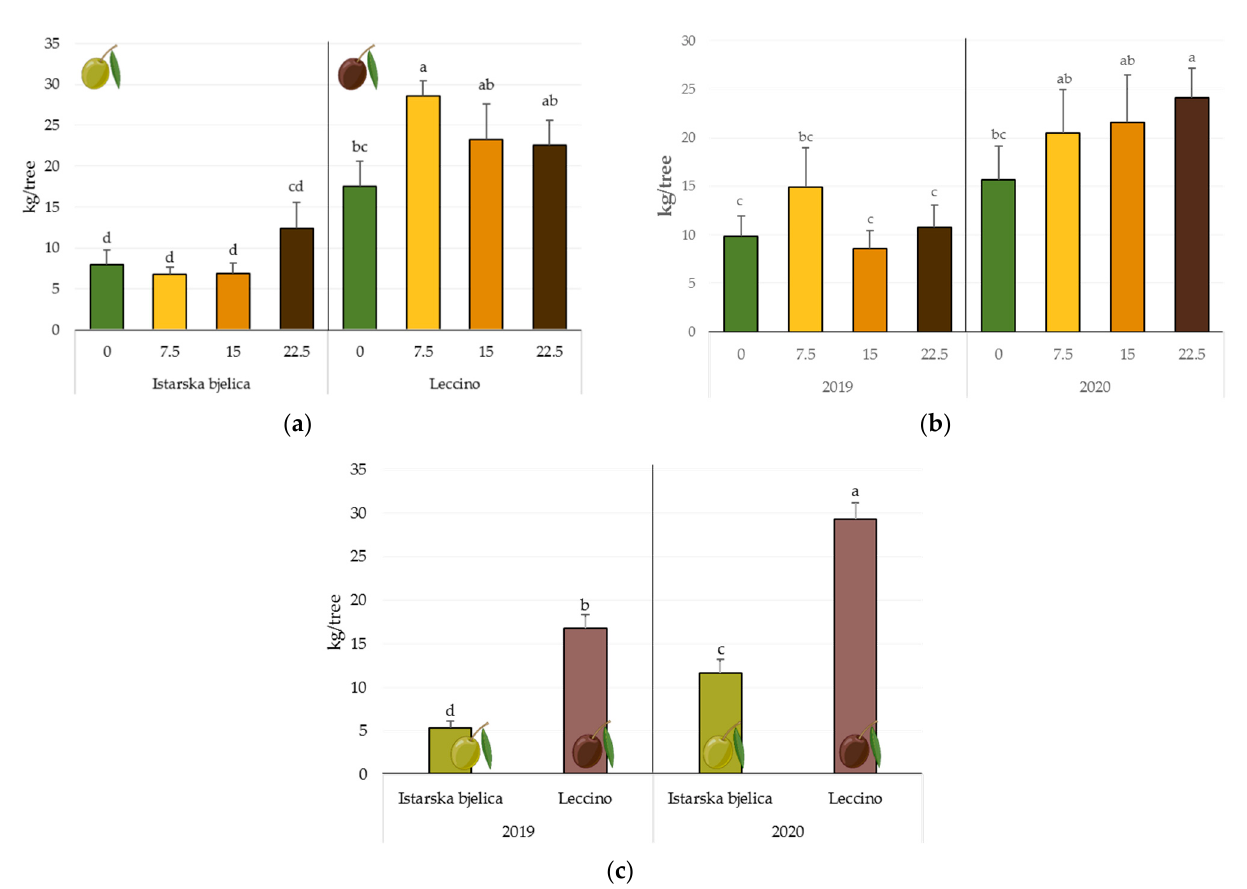
Figure 3. Multiple comparisons of the effects of ( a ) treatment (T) (0, 7.5, 15, and 22.5 mL of applied SN foliar fertilizer per 1 L of water) and cultivar (Cv.) (Istarska bjelica, Leccino), ( b ) treatment and year (Y) (2019, 2020), and ( c ) cultivar and year on olive fruit yield. Different superscript lowercase letters represent statistically significant differences between mean values at p < 0.05 obtained by a three-way ANOVA and Tukey’s test.